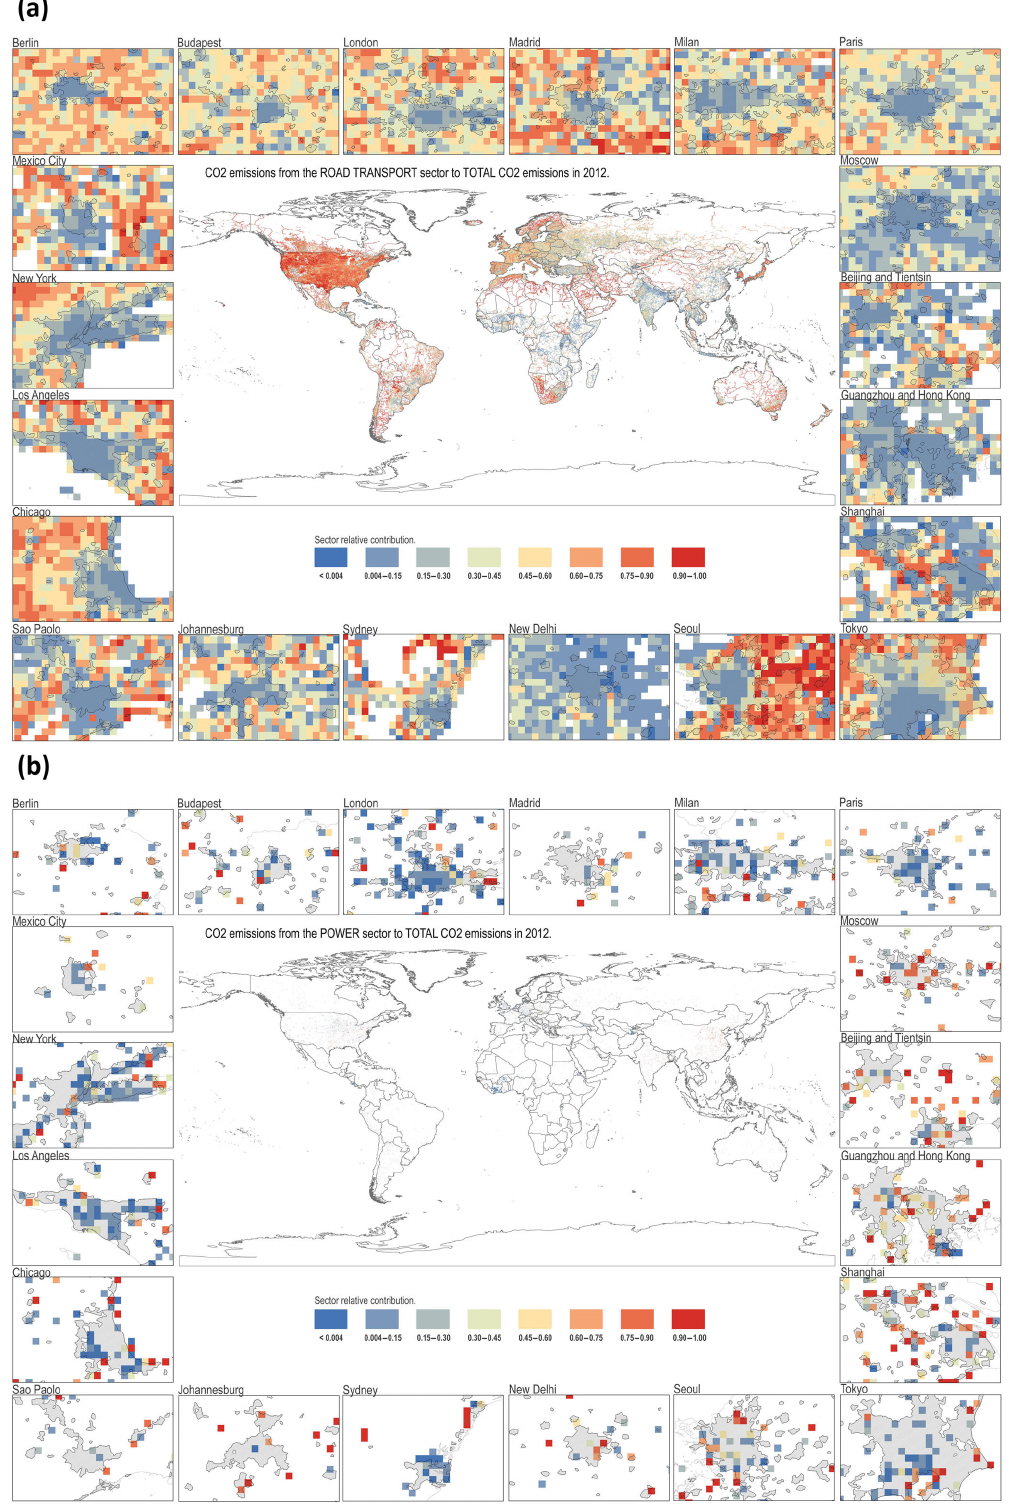
Figure 10. (a) Zoom of CO 2 emission grid maps over cities, representing the share of the road transport within the cities. The represented CO 2 emissions also include those from short-cycle carbon. (b) Zoom of CO 2 emission grid maps over cities, representing the share of the power plants within the cities. The represented CO 2 emissions also include those from short-cycle